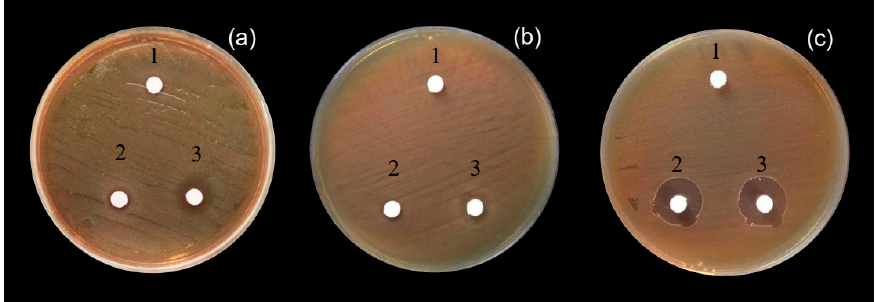
Figure 4. Antimicrobial activity of cell-free culture supernatant (CFCS) obtained from L. plantarum S21 cultivation in the optimized medium at 37 °C for 48 h against E. coli ATCC 25922 ( a ), S. enterica serovar Typhimurium TISTR 292 ( b ), V. cholerae TH-001 ( c ); deionized water (1), neutralized CFCS (2), and non-neutralized CFCS (3).